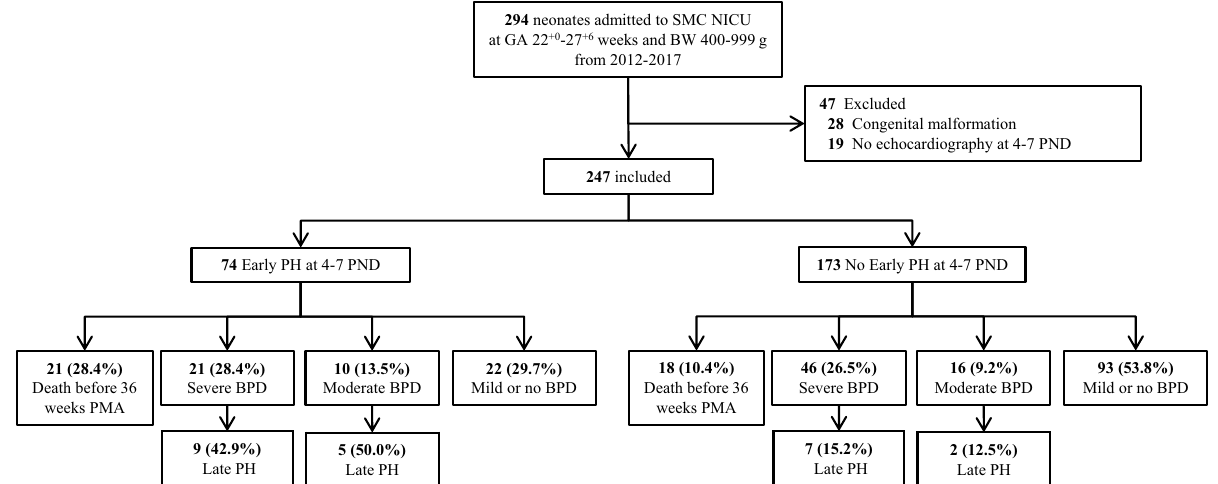
Figure 1. The study population. SMC Samsung Medical Center, NICU neonatal intensive care unit, GA gestational age, BW birthweight, PND postnatal days, PH pulmonary hypertension, BPD bronchopulmonary